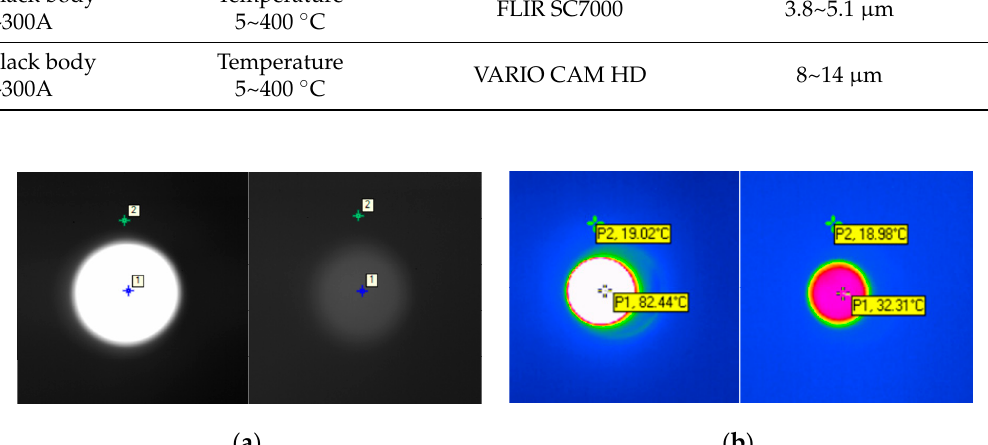
Figure 6. Broadband extinction performance test system for bioaerosols.